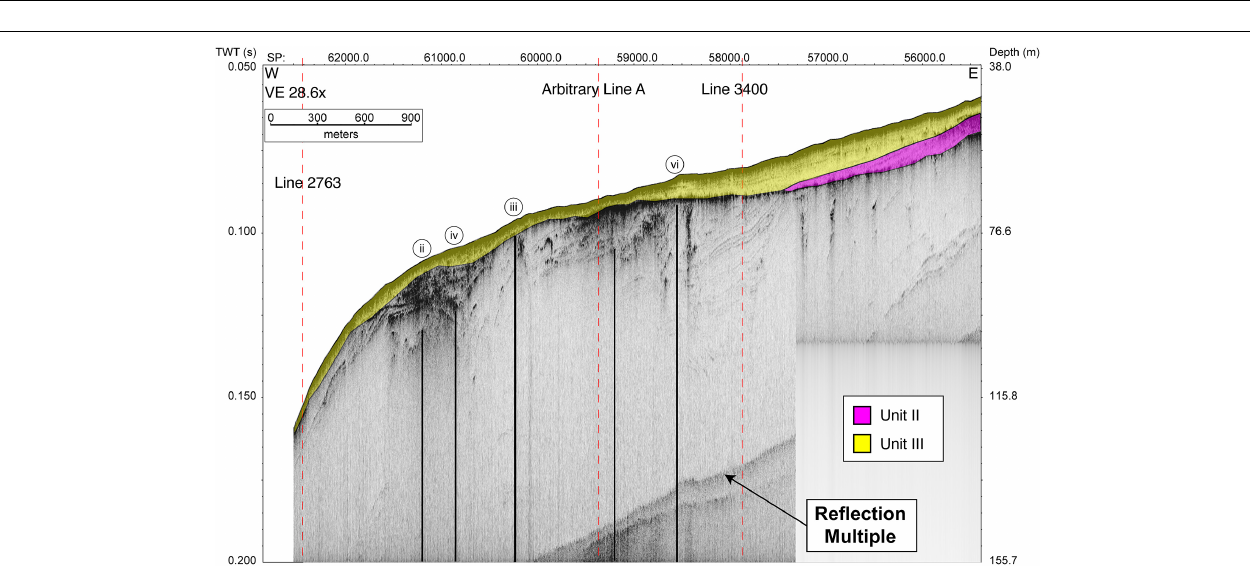
FIGURE 9 | Interpreted stair diagram of Crossline 3400 bounded by time-slices at 125 and 350 ms. Time-slices are displayed as a combination of similarity data and amplitude data at 60% transparency. Major fault segments are labeled. This crossline cuts through the middle of the large anticline structure observed in Zone Two of the survey area. Lower time-slice shows fault segments delineating an acoustically transparent to semi-transparent region in the middle of the time-slice. Note some of the faults exhibit a more northwesterly trend in this region. Solid green line delineates stratigraphic horizon recording the onset of deformation (lowest depth is 200 ms or ∼ 156 m). Dashed green line shown where horizon is inferred. Locations of seismic lines are shown in Figure 1C .